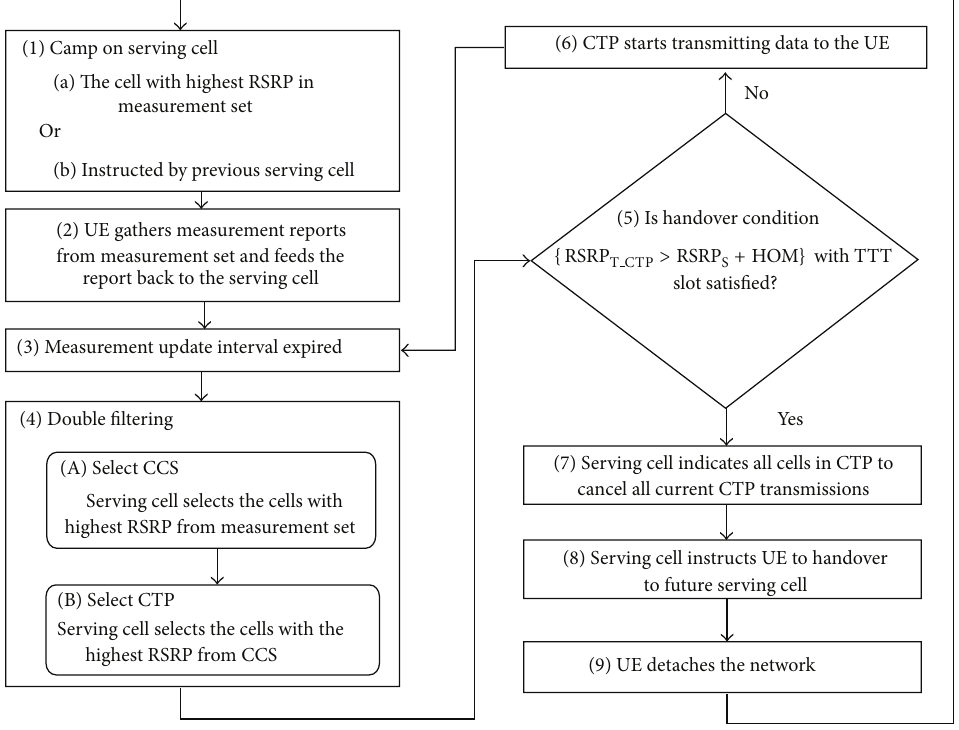
Figure 4: Flowchart of CoMP Handover Algorithm in